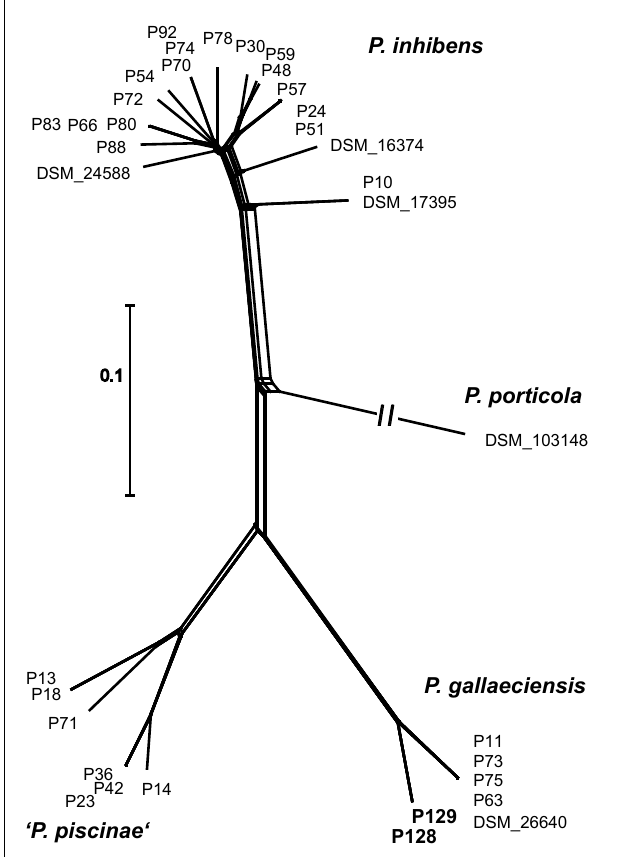
FIGURE 4 | Phylogenetic network of 35 Phaeobacter strains inferred by NeighborNet analysis from 68858 core-genome SNPs estimated by Parsnp. Scale bar, 0.1 changes per polymorphic site. The long branch to P. porticola is depicted incompletely and Pacific strains are highlighted in bold.